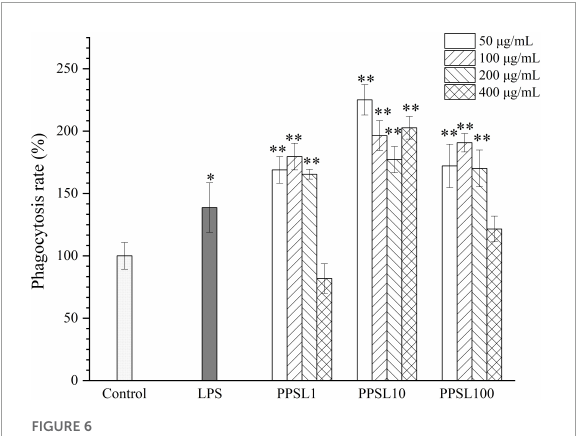
FIGURE6 Effects of different concentrations of three PPSLs fractions (50, 100, 200, and 400 µ g/mL) on phagocytic activities in RAW264.7 macrophages. ∗ p < 0.05, ∗∗ p < 0.01 vs. control group.